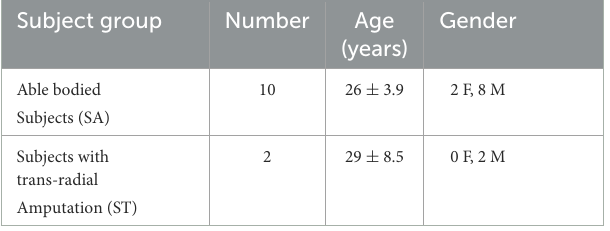
TABLE 1 Subjects were in the following results of able-bodied subjects are indicated as (SA) and for subjects with trans-radial Amputation as